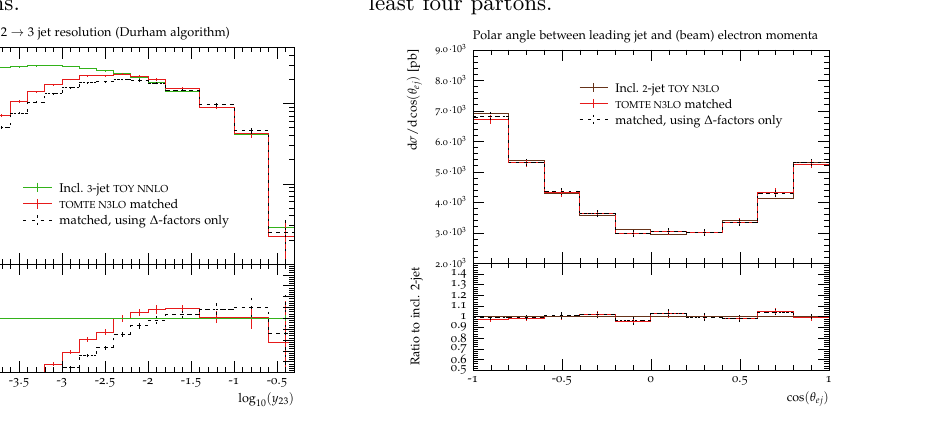
(d) Angle of the leading jet and the electron, when (c) Separation of the 2nd and 3rd hardest jets, as always clustering to two jets, as proxy for two- proxy for (inclusive) observables depending on at parton observables. least three partons. Figure 2 . Comparison of toy fixed-order curves (with conservative S (Φ n ) regularization), toy matching applying only Sudakov factors, and full Tomte results. Plots were produced with Rivet [87]. Bars denote statistical